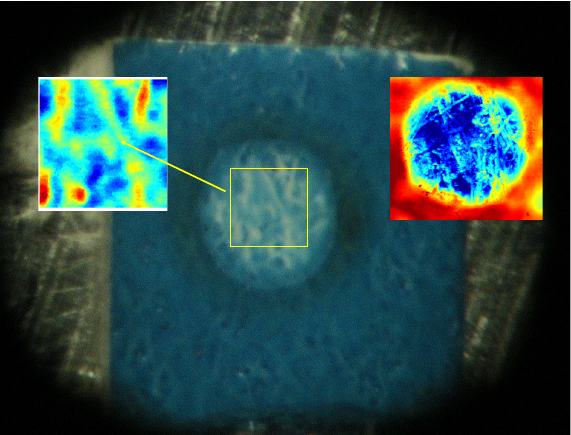
Figure 8. Microscopic image of a typical crater bottom, where most of the toner and coating were removed. Inserts show spatial toner distribution obtained from elemental LIBS information. Ob- serve the role of fibers in fixing the toner. Blue color refers to low and red color to high toner con- centration, respectively.